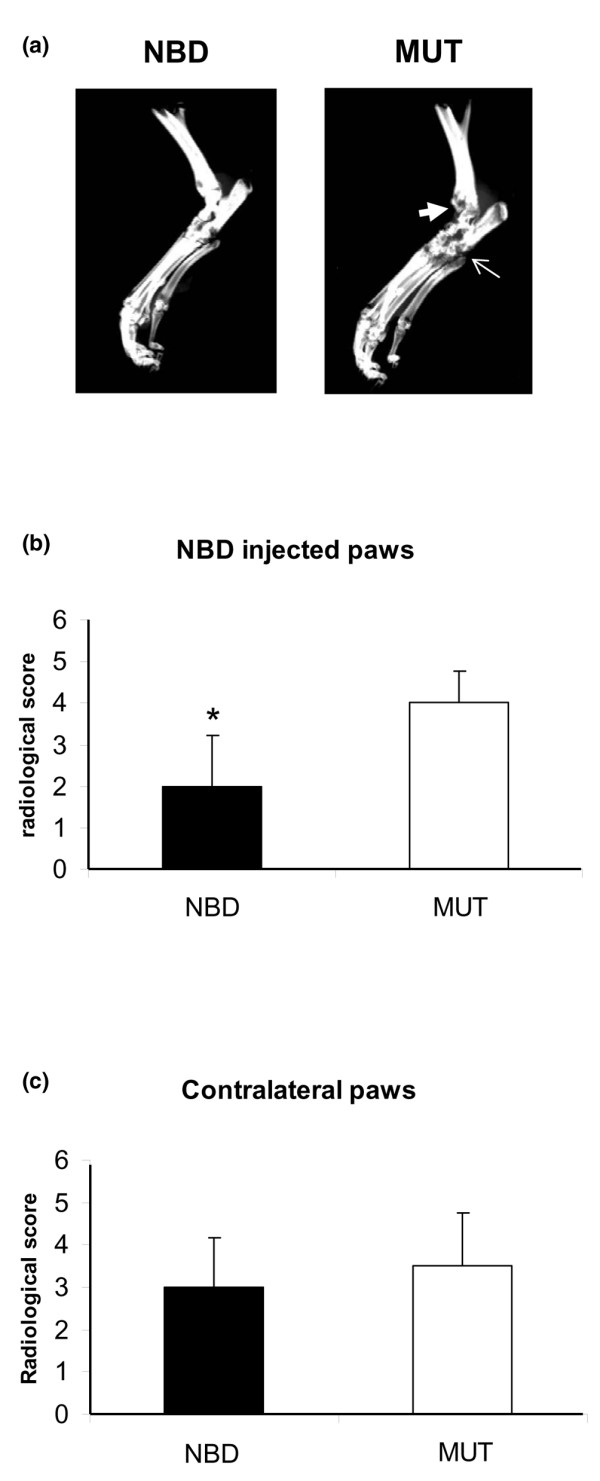
Nuclear factor-κB essential modulator binding domain (NBD) peptide treatment significantly reduces bone destruction. (a) X-rays of the ankle joints (n = 10/group) were made, and radiological damage was scored. Representative pictures for NBD- and mutant NBD (MUT)-treated ankle joints are shown. Large arrow indicates ankle demineralization. Small arrow indicates midfoot demineralization and erosions. (b) NBD peptide treatment significantly reduces bone destruction. Data represent mean ± standard error of the mean (SEM) radiological scores (*p < 0.04). (c) No significant difference in bone destruction was observed in the contralateral, non-injected paws. Data represent mean ± SEM radiological scores.